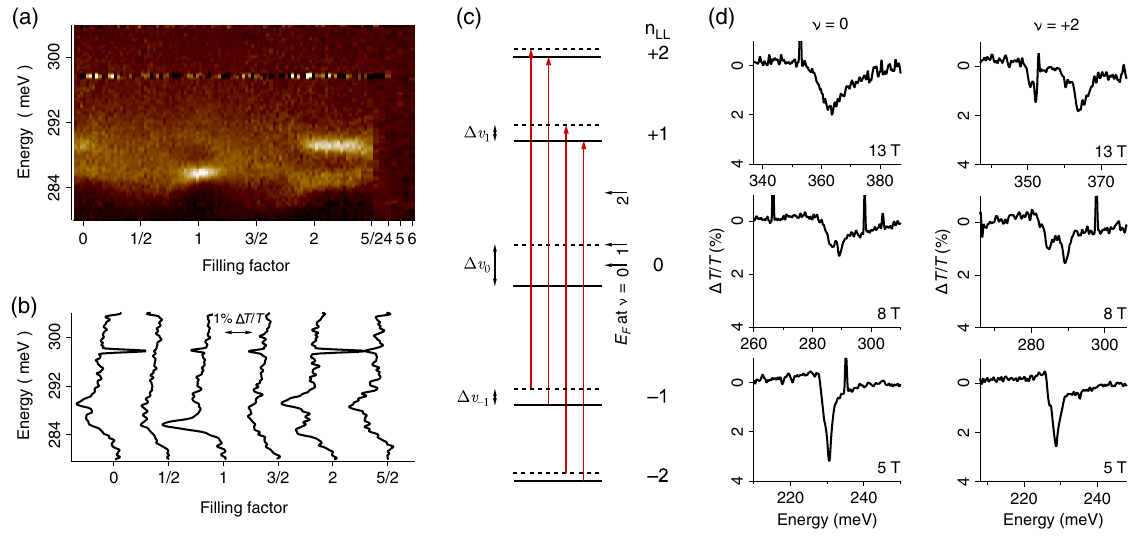
FIG. 6. Evolution of the second interband transition T 2 vs filling factor. (a) High-resolution map of T 2 for the same filling factor range as Fig. 1. The horizontal band at 298 meV is due to the harmonics of 60 Hz. Two peaks are just resolved at ν ¼ 0 , while the spectrum is dominated by a single peak at ν ¼ þ 1 , and two peaks appear again at ν ¼ þ 2 , albeit with more intensity in the higher peak. The resonances are broader than those at T 1 and exhibit a high energy tail, which may be the result of multiple reflections in the substrate [25]. (b) Line cuts at half-integer filling factors. (c) Schematic of T 2 transitions, with the K ( K 0 ) valley showing as a solid (dashed) line. Zeeman splittings are suppressed. (d) Spectra at ν ¼ 0 and þ 2 as a function of magnetic field. A remarkably large splitting, nearly 13 meV in size, appears at ν ¼ þ 2 at 13